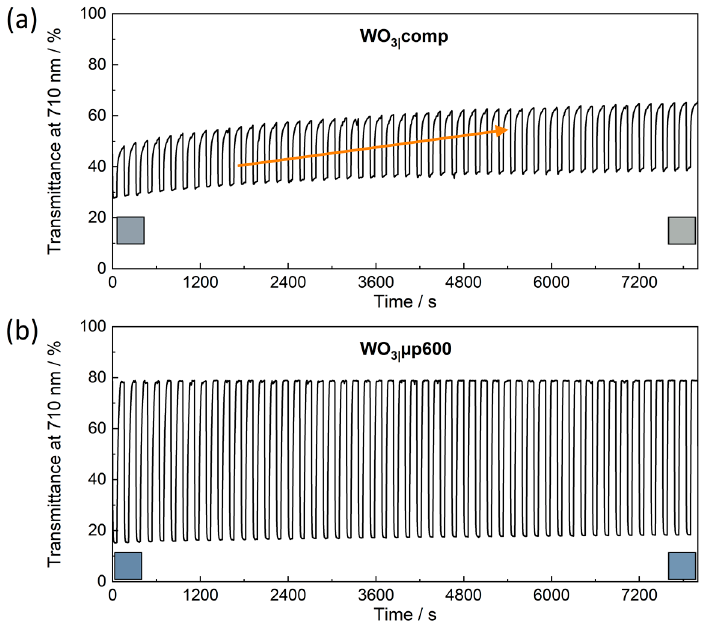
Figure 10. Optical transmittance at 710 nm of ( a ) WO 3| comp and ( b ) WO 3| µ p600 in LiClO 4 in PC, recorded during chronoamperometry with 50 cycles between − 1 V applied for 60 s and 1 V applied for 100 s. The arrow in ( a ) indicates the shift of the transmittance to higher values. The insets show the calculated color impressions at the 4. And the 53. Cycle of the films at the colored states.